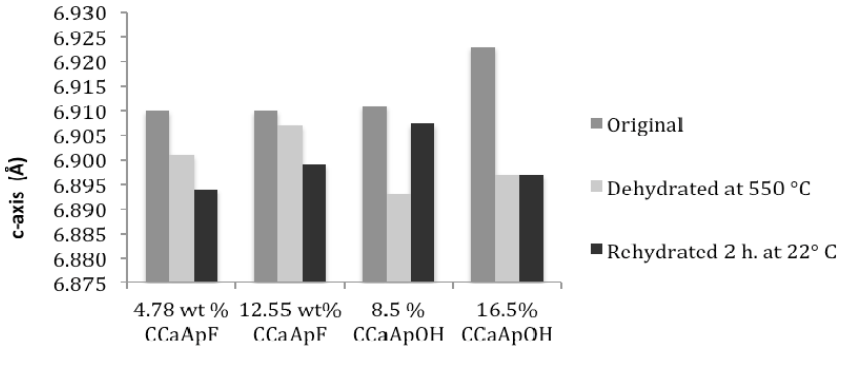
Figure 13. Variation in c-axis length for two fluor- and two hydroxylapatites, showing the effect of dehydration and